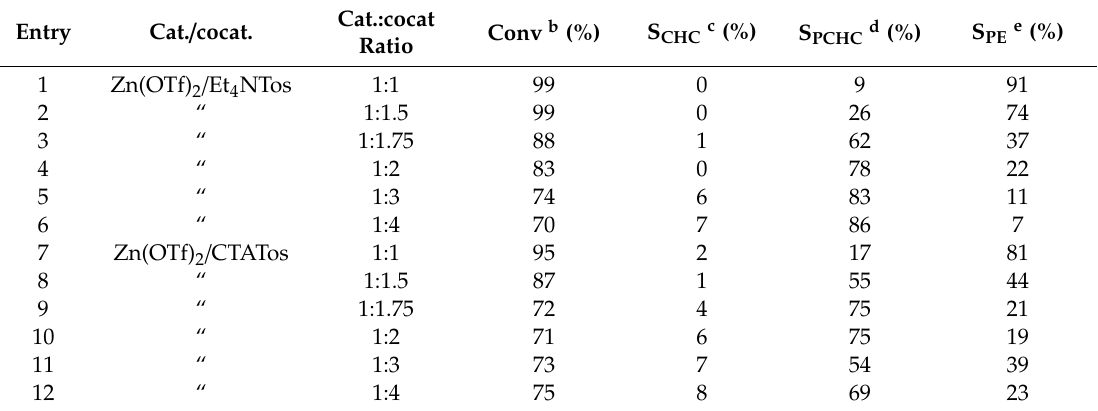
Table 3. Catalytic studies performed with Zn(OTf) 2 / Et 4 NTos and Zn(OTf) 2 / CTATos catalytic platforms using various catalyst:cocatalyst ratios a